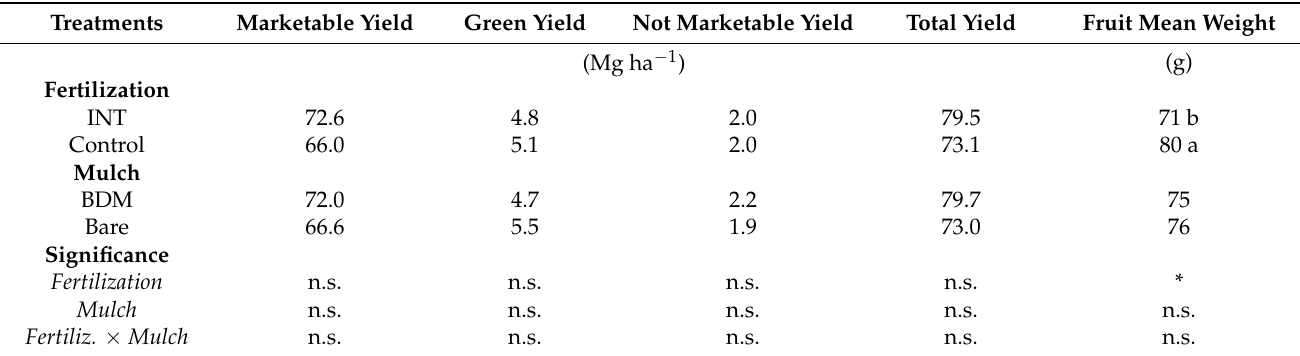
Table 5. Total yield and its composition, fruit mean weight of tomato cv Kendras, in 2018, expressed as mean effect of Fertilization and